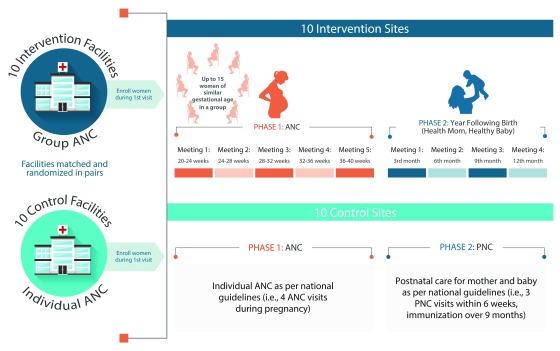
Study design.Description of randomization to intervention and control group and the intervention package for each study group.